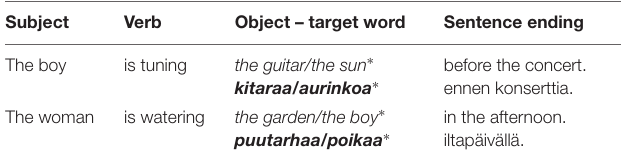
TABLE 3 | Examples of experimental stimuli. Incongruent words are starred with a ∗ , language switches are displayed in